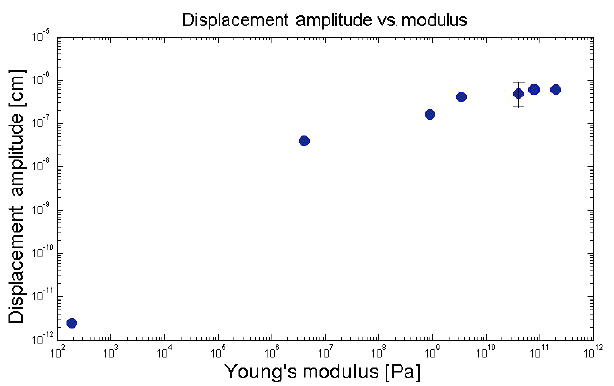
Figure 11. Average peak-to-peak displacement at the bottom of the rod as a function of Young’s modulus of the bond materials as simulated with the COMSOL FEM model. The numerical val- ues for various types of bonds are given in Table 4. The point with the error bars is placed by fitting the displacement amplitude given the estimated modulus of the spray-on low-temperature bond. Bond strength appears to lie between the commercial glue and the epoxy bonds.